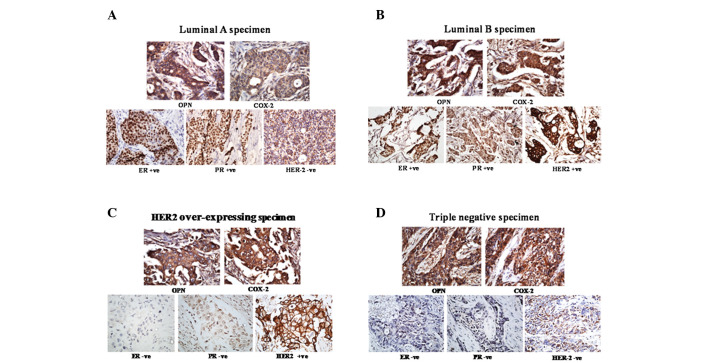
Representative images of osteopontin (OPN) and cyclooxygenase-2 (COX-2) expression in the breast cancer subtypes, including (A) luminal A (B) luminal B, (C) HER2-overexpressing and (D) triple negative subtypes. HER2, human epidermal growth factor receptor type 2. DAB staining; magnification, ×40.